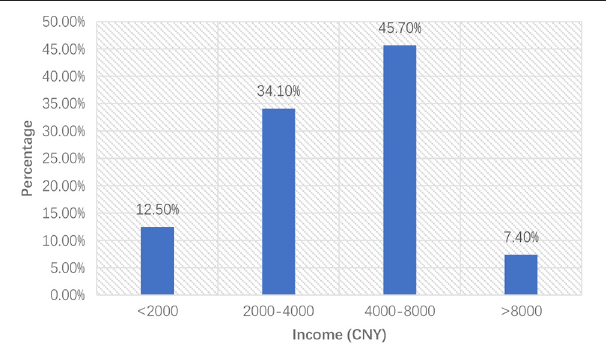
FIGURE 4 | Monthly income of Meituan food delivery knights.